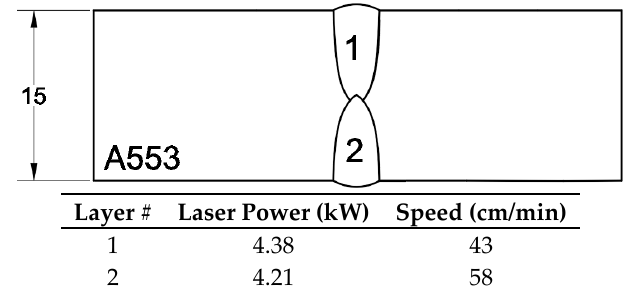
Figure 1. Butt LBW conditions of A553-1 (15 mm thickness).